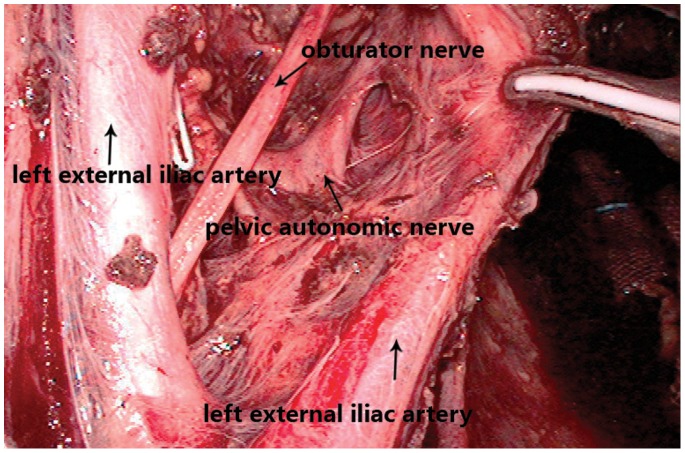
Preservation of pelvic autonomic nerve plexus when dissecting the obturator lymph nodes.This procedure is difficult not only because of the narrow space, but also concentrated pelvic autonomic nerve. Operation by laparoscopic technique here can occupy small space and identify tissues clearly. By this technique, the purpose of lymph nodes remove and autonomic nerve preservation could be achieved.